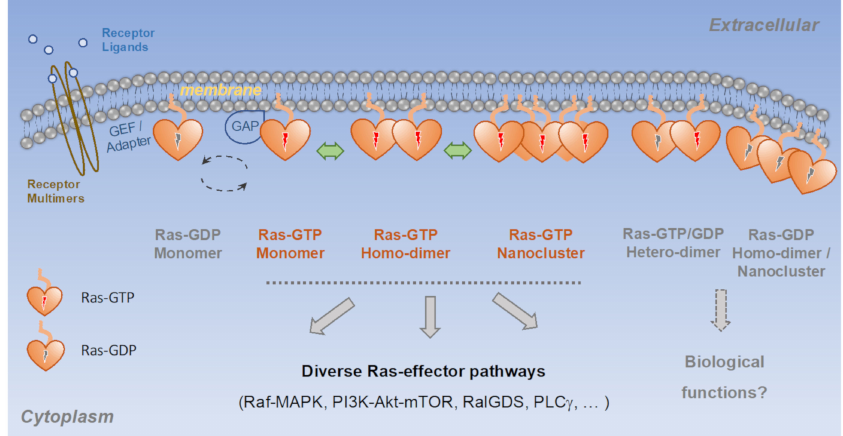
Figure 2. Ras dimers and nanoclusters in biological processes. Current evidence suggests that Ras exists as a mixture of monomers, dimers, and higher order multimers, where dimers and multimers could be homotypic, comprising either GTP- or GDP-bound Ras, or heterotypic, comprising both GTP- and GDP-bound Ras. At present, the physiological relevance of many of the Ras multimers remains